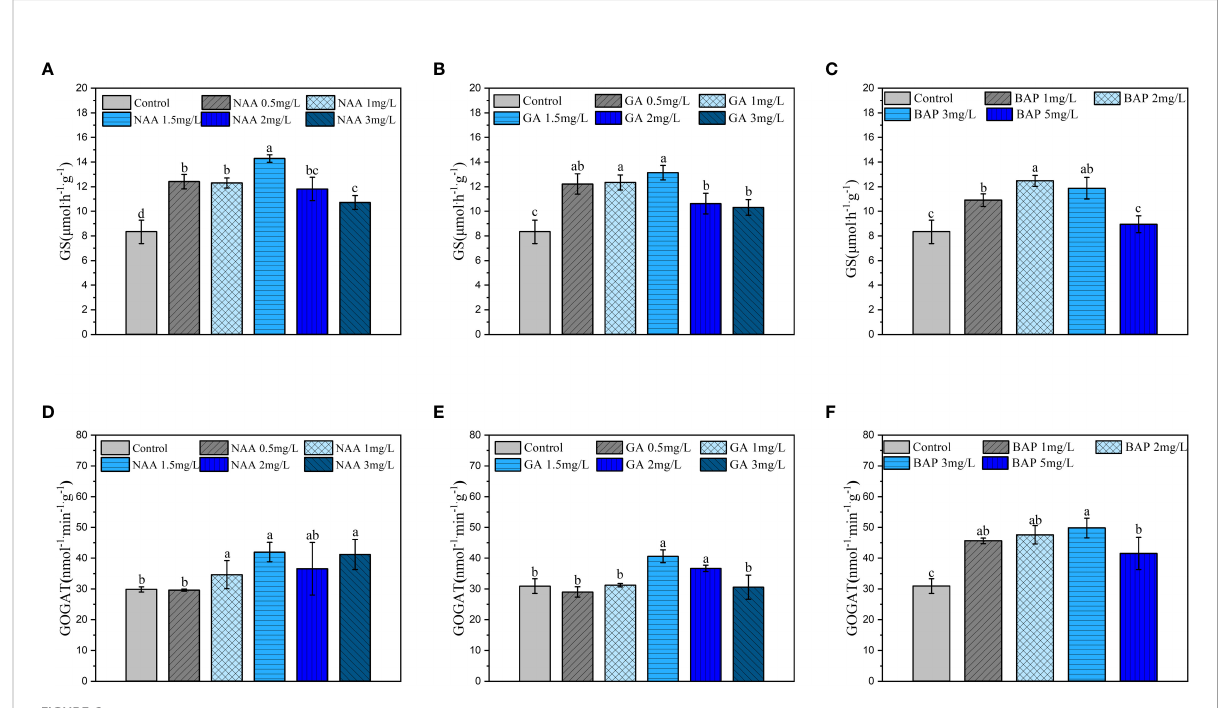
FIGURE 6 Effects of three exogenous hormones on nitrogen assimilation by Sargassum fusiforme holdfasts. (A – C) : glutamine synthetase (GS) activity in holdfasts under different culture conditions; (D – F) : glutamate synthase (GOGAT) activity in holdfasts under different culture conditions. Values are the mean ± standard deviation (n = 3). Different letters indicate signi fi cant differences between different culture conditions (p <